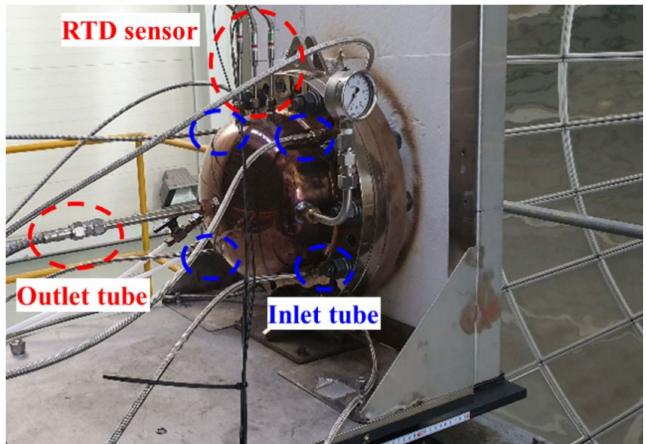
Figure 6. Direct heating reactor with quartz